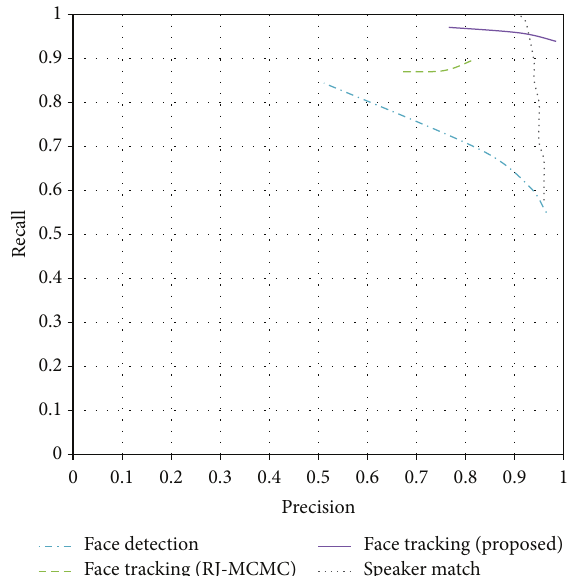
Figure 12: Recall versus precision for face detection, face tracking, andspeakermatch(Dataset1).Bothfacetrackingandspeakermatch show good performance as there are only two participants within a sector of 100 ∘ .